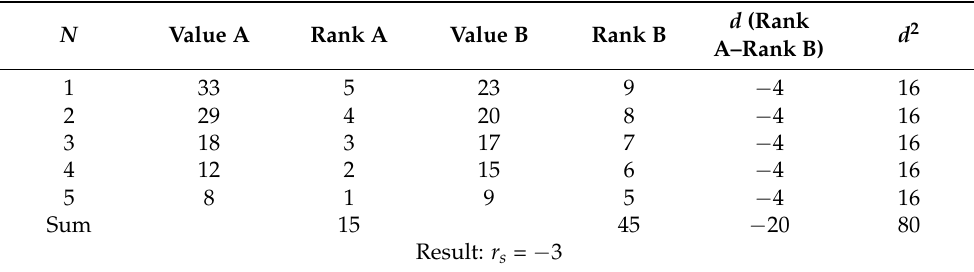
Table 4. Determination of Spearman’s rank linear correlation indicator based on the ratio of the degree of satisfaction with the use of ICT and the assessment of the main automated business processes in the activities of industrial enterprises of the Republic of Mordovia.